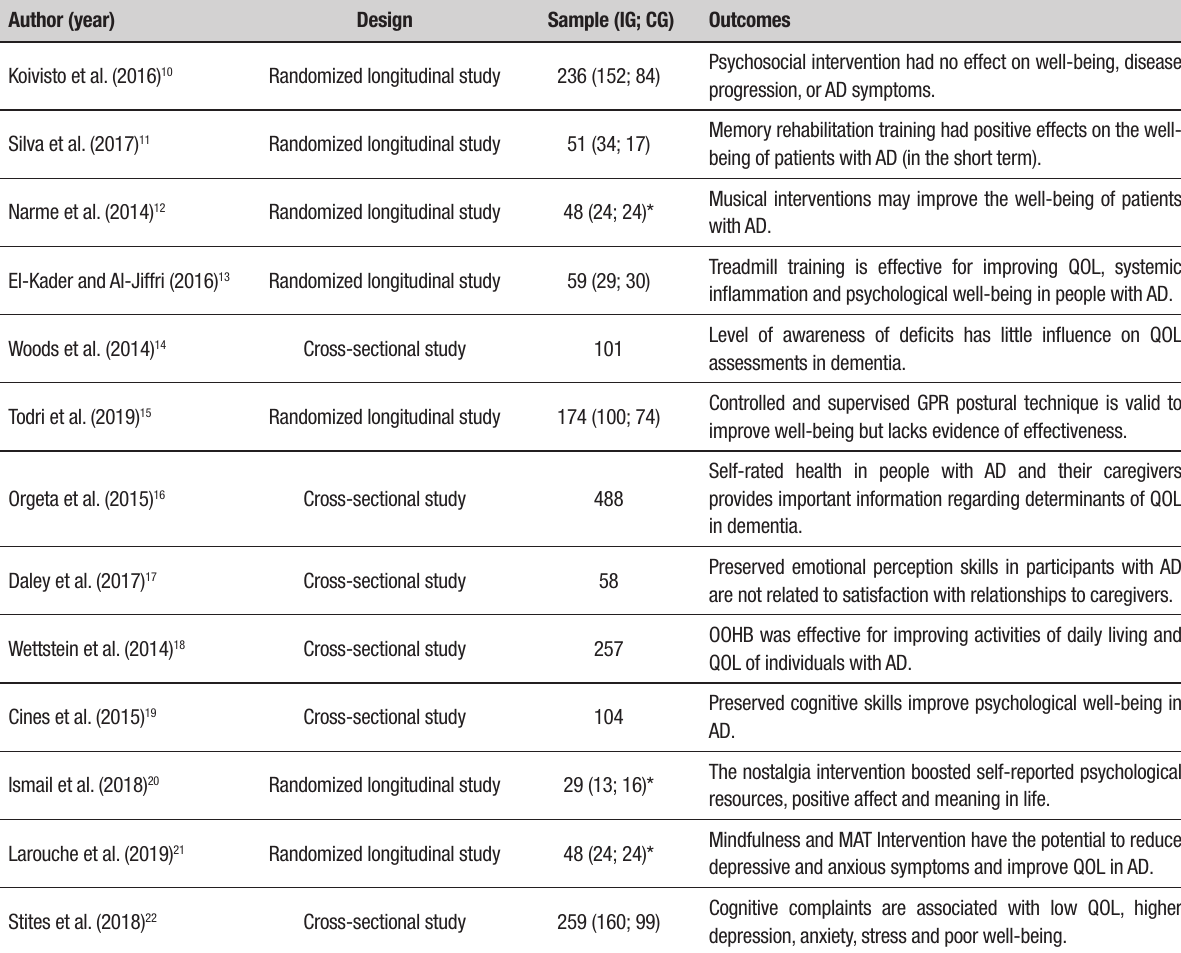
Table 1. Data extracted from selected articles